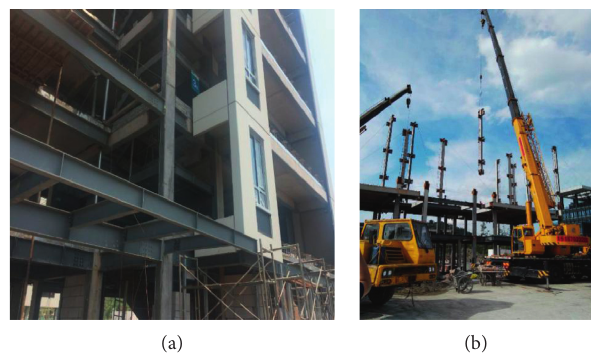
Figure 1: PEC frame structures in the Meishanjiang project.